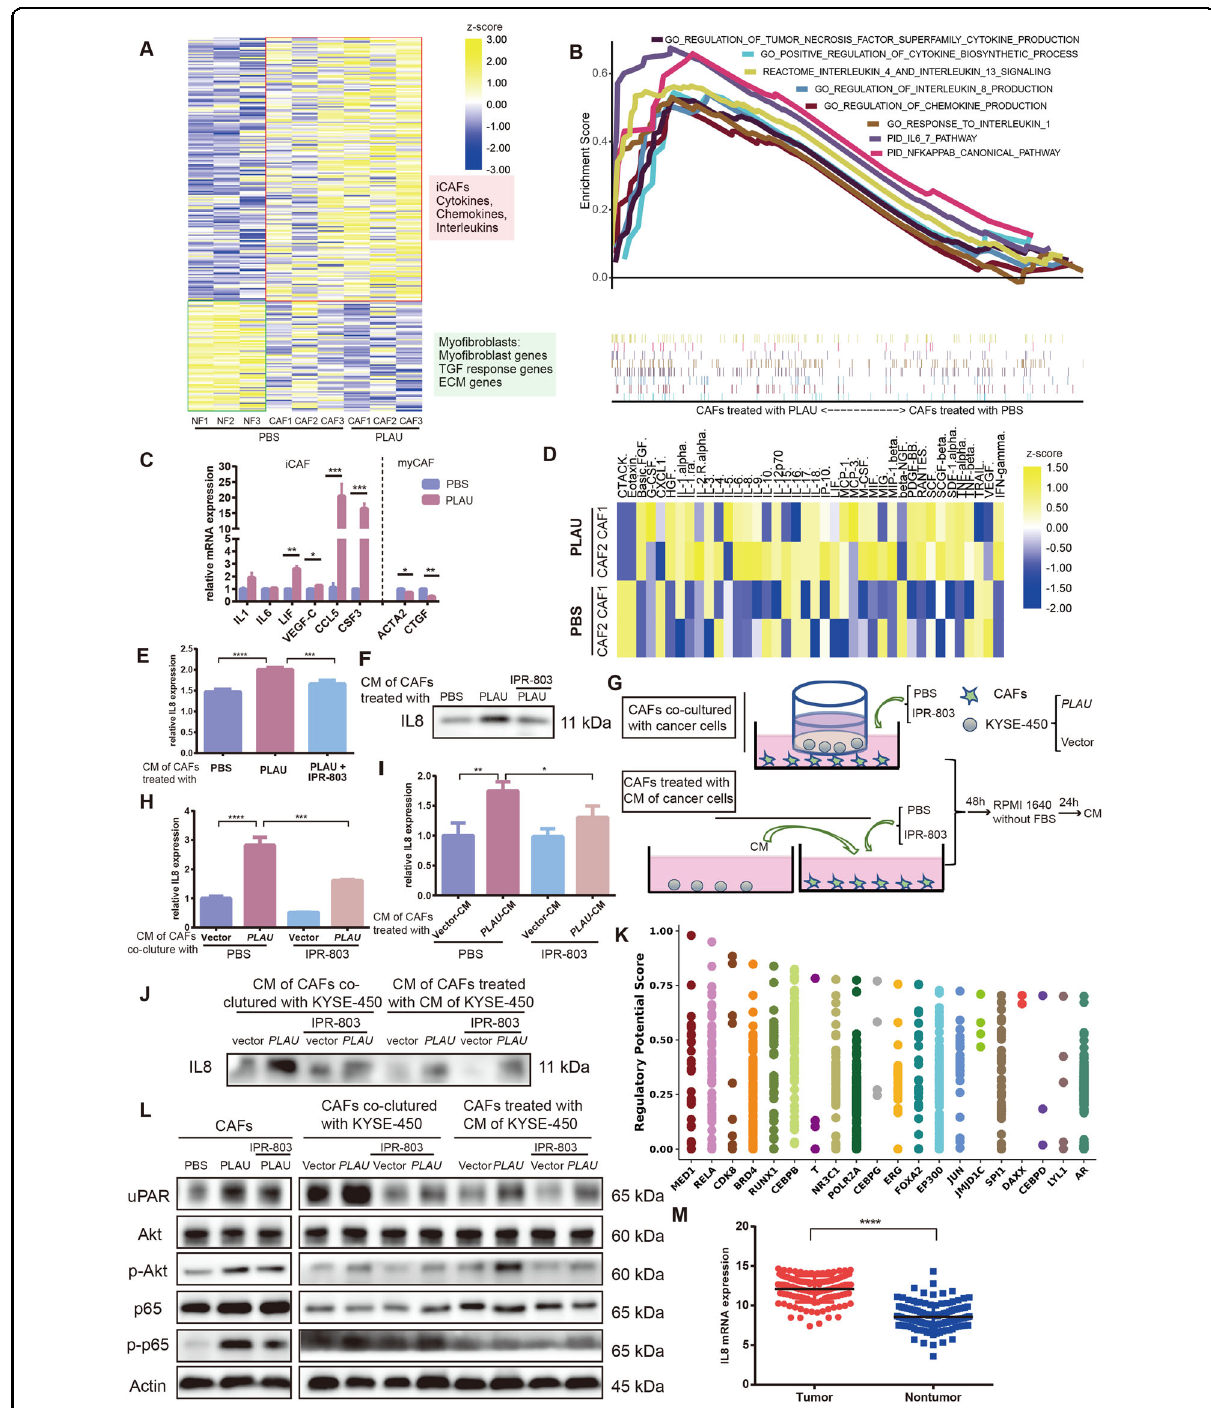
exhibit upregulation of gene sets of iCAFs and down- regulation of gene sets of myCAFs (Fig. 6A). In addition, PLAU stimulated the activation of cytokine or chemokine pathways in CAFs (Fig. 6B). We hypothesized that